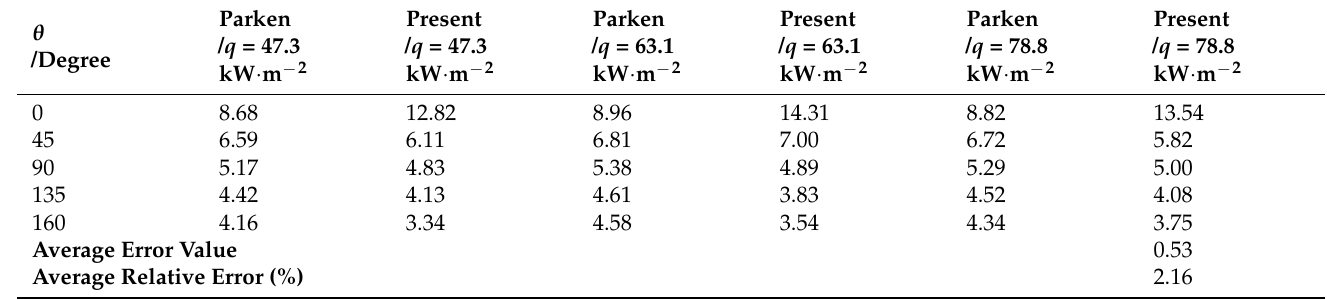
Table 6. Comparison between present study and previous experimental study